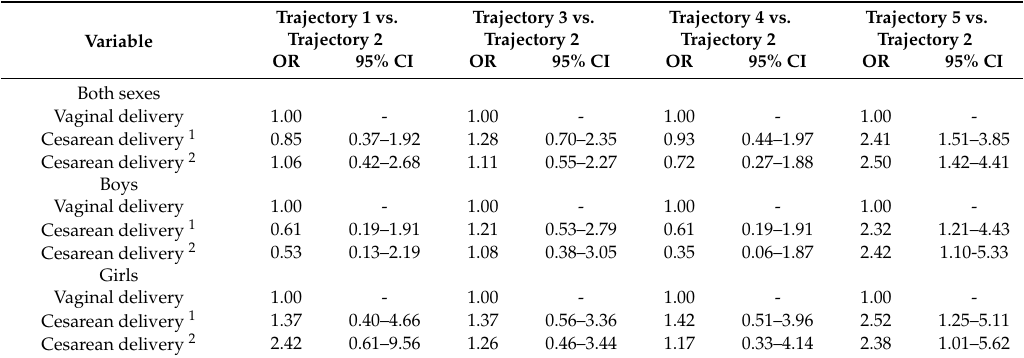
Table 2. Crude and multivariable-adjusted odds ratios (OR) and 95% confidence intervals (CI) for o ff spring obesity trajectories associated with Cesarean vs. vaginal delivery.